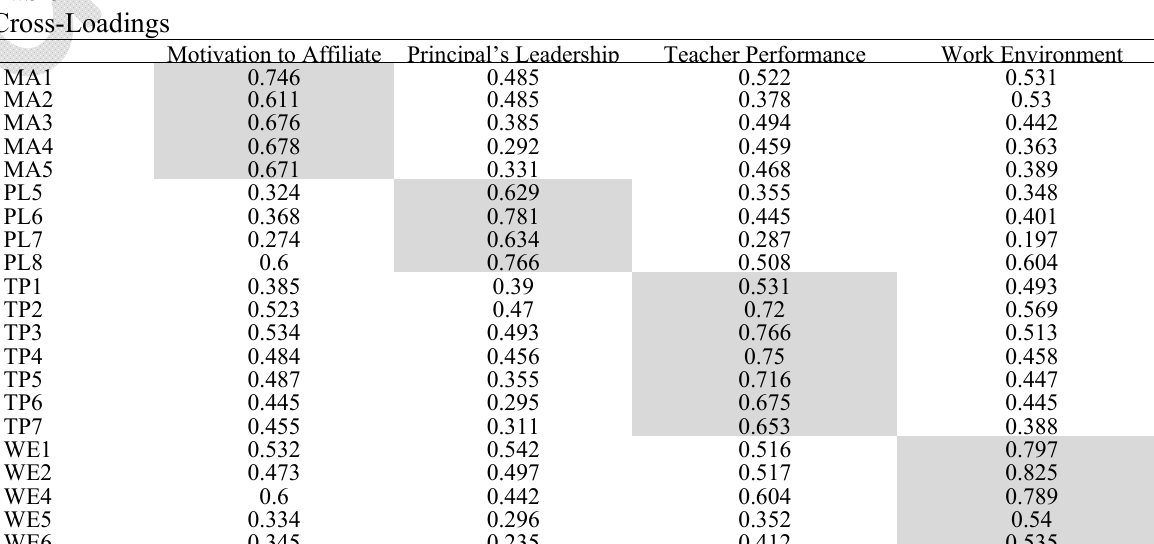
Construct Reliability and Validity